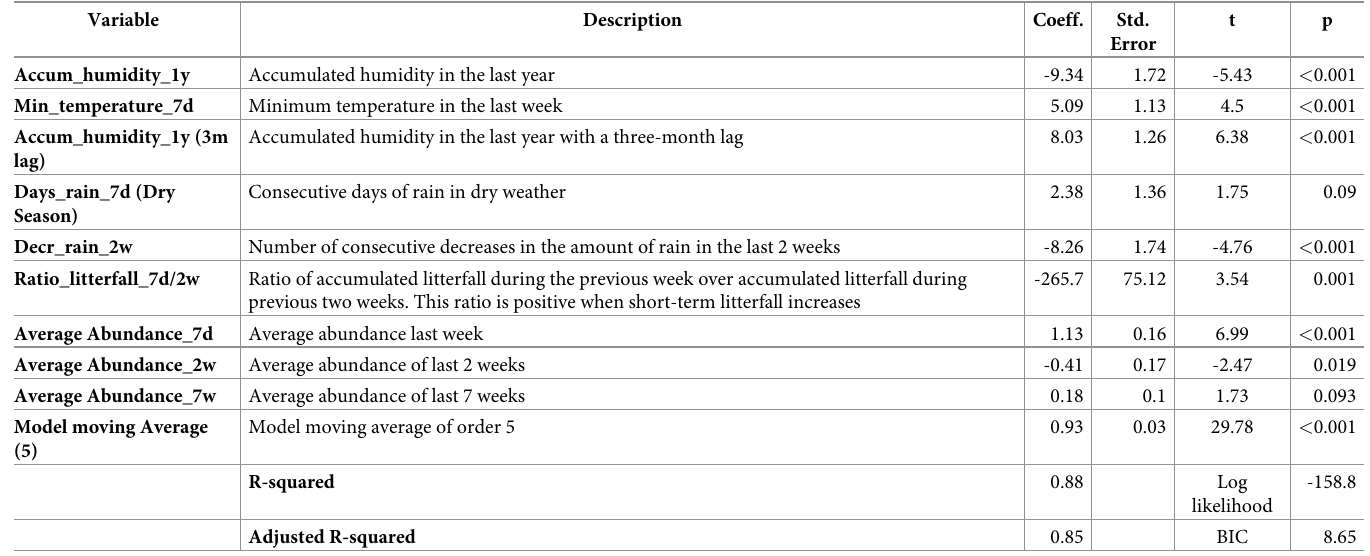
Table 1. Description of variables included final SARIMAX